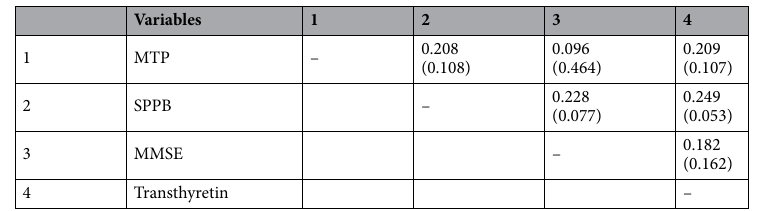
Table 4. Correlation matrix among variables in subgroup analysis. Values are correlation coefficient and ( P value). MMSE Mini-mental state examination, MTP Maximum tongue pressure, SPPB Short physical performance